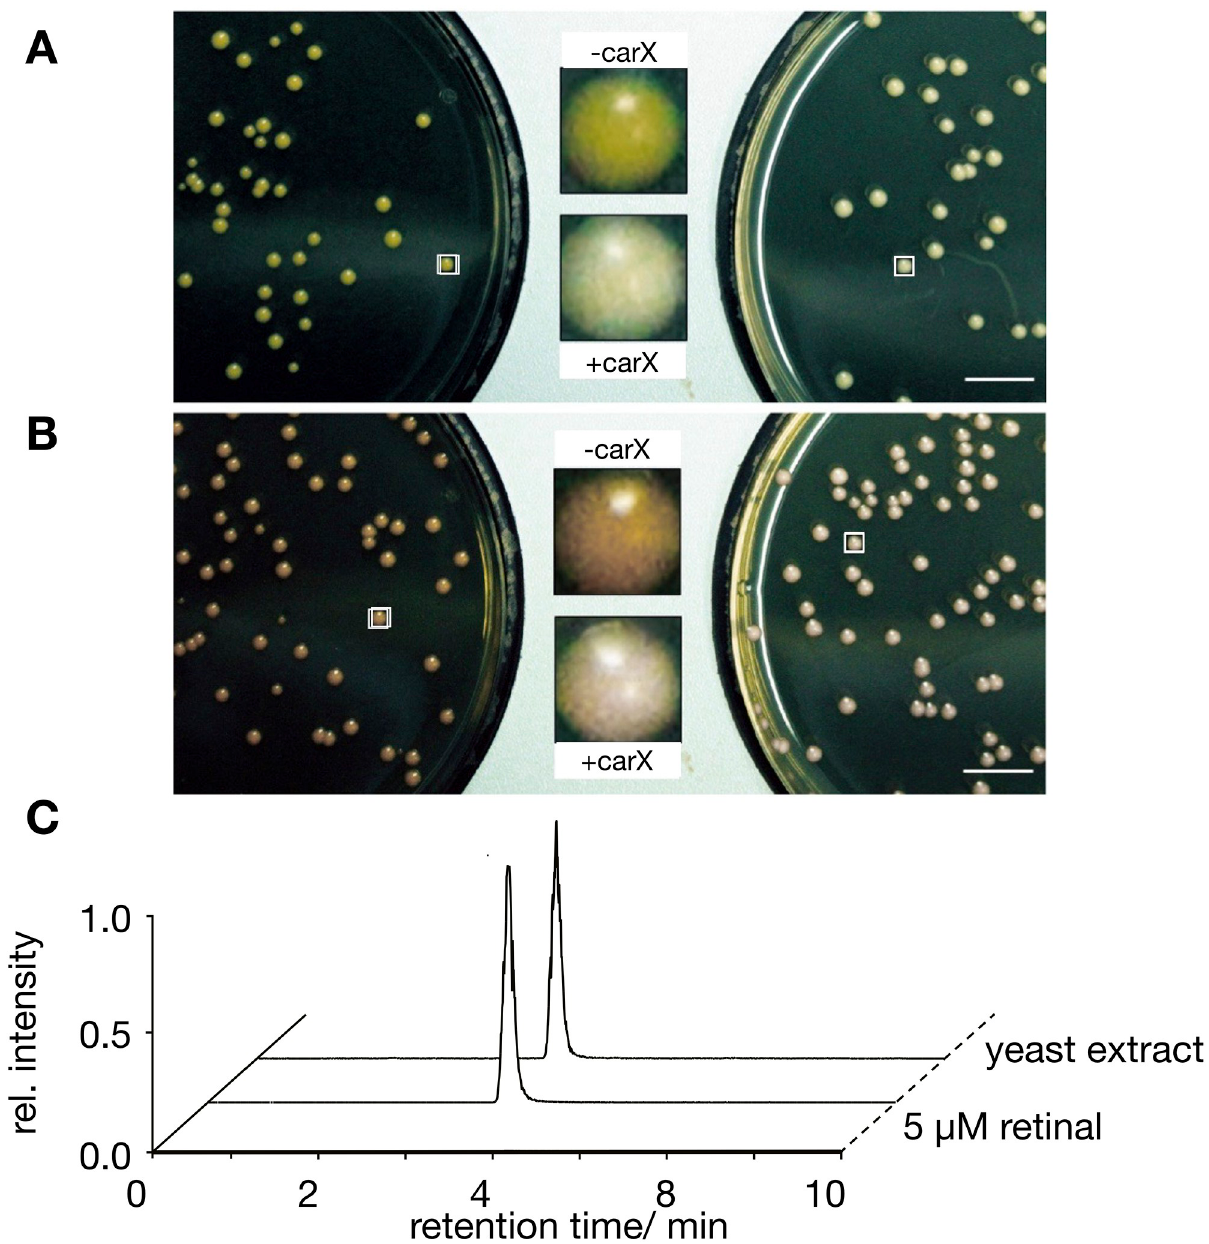
Fig 3. Engineering of retinal producing yeast. (A) PLY240 cells with genomic integration of the polycistronic construct for β -carotene production without (left) and with the carotenoid monooxygenase carX (right) were plated at 1:10 4 dilution on nonselective medium containing a high K + concentration to yield single colonies. (B) trk1 Δ trk2 Δ cells with genomic integration of the polycistronic construct for β -carotene production and a second crtI gene without (left) and with (right) the carotenoid monooxygenase carX plated as in A . The colonies highlighted by frames are magnified and shown in the center. Images in A and B were taken after 4 days of incubation. Scale bar = 10 mm. (C) UPLC analysis of retinal production in yeast. Ethanol extract from trk1 Δ trk2 Δ yeast cells as in B with the genomically integrated polycistronic β -carotene pathway, a second crtI gene and carX was used for UPLC analysis with 5 μ M all- trans retinal as reference. Data were normalized to the largest peak in the chromatograms. The analysis shows the same elution behavior of the extract as for the reference with a signal at 3.54 min indicating production of all- trans retinal in yeast cells.